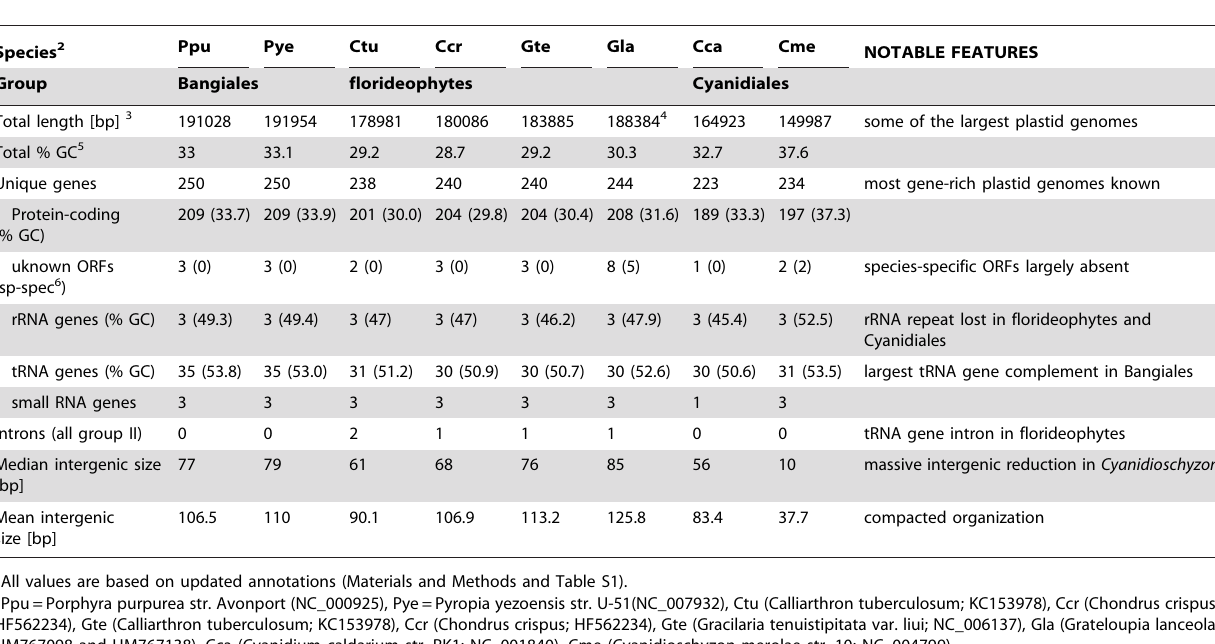
Table 1. General characteristics of red algal plastid genomes 1 .